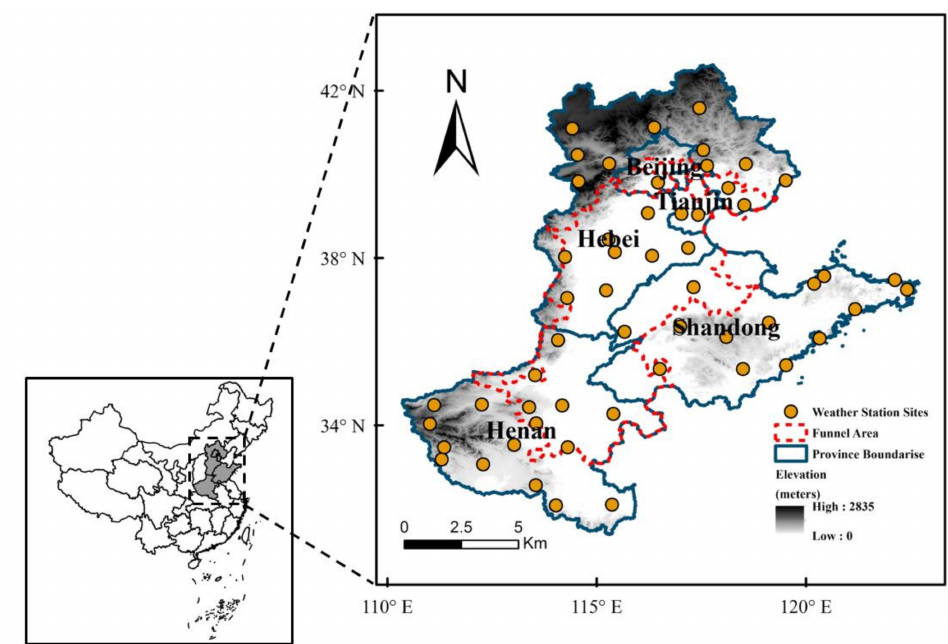
Figure 1. Location of North China District and the weather station